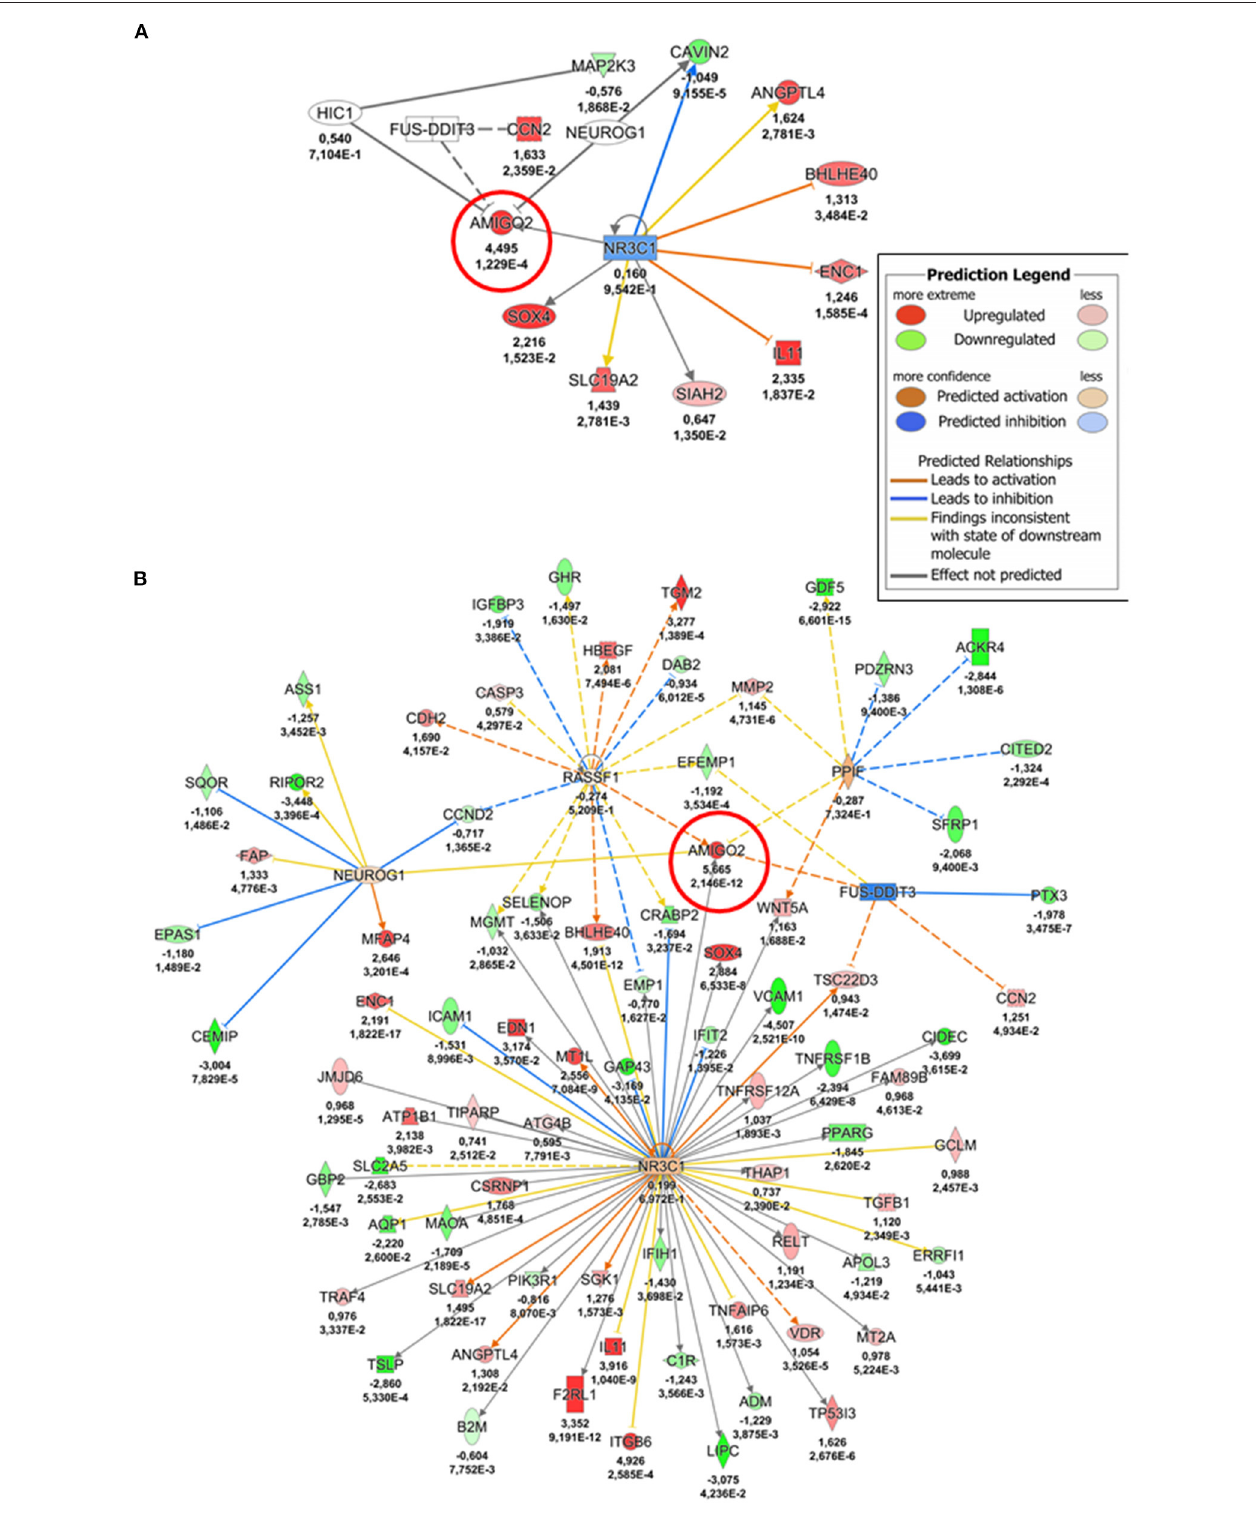
FIGURE 6 | AMIGO2 upstream regulators-gene interaction networks. (A) Network depicting AMIGO2 upstream regulators predicted activity at 24h (24 h dyn vs. 24h stat). (B) Network depicting AMIGO2 upstream regulators predicted activity at 72h (72 h dyn vs. 72h stat). The values underneath each gene (when expressed in the dataset) indicate respectively the logFC and the adjusted p -value from the DE analysis. AMIGO2 is circled in red.